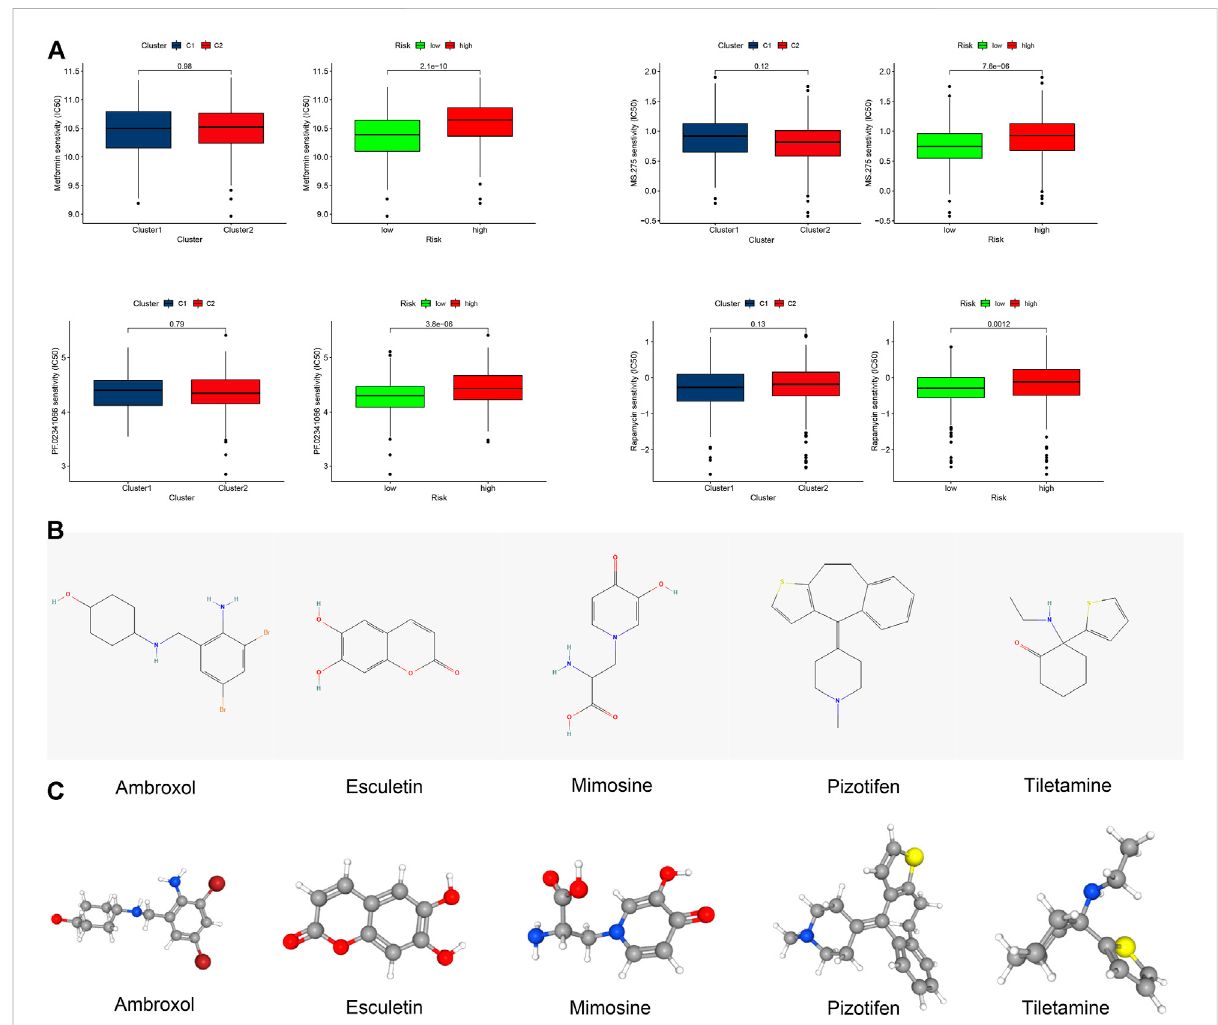
FIGURE 7 Clinical prediction of drug sensitivity in CM cases between two clusters or two risk groups. (A) Four potential drugs solely had signi fi cant IC 50 differences between these two risk groups. (B,C) 2D structure illustrations and the 3D structure tomography of fi ve candidate small-molecule drugs for CM. A p value of < 0.05 was considered to indicate a statistically signi fi cant